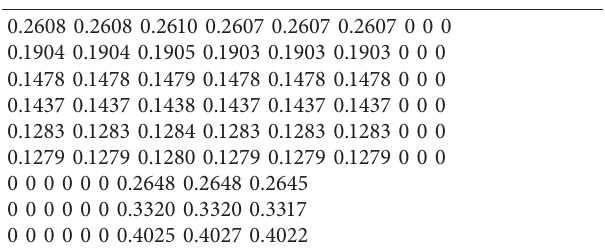
Table 10: Limit matrix.